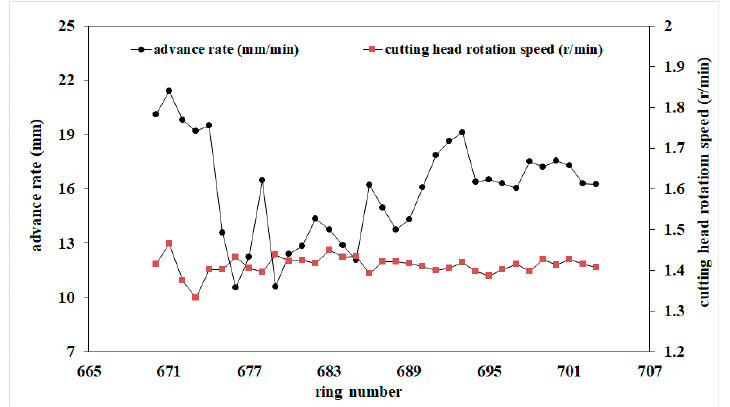
Figure 11. Changes of advance rate and cutting head rotation speed of the machine at the Jinan Huanghe River Crossing tunnel construction.